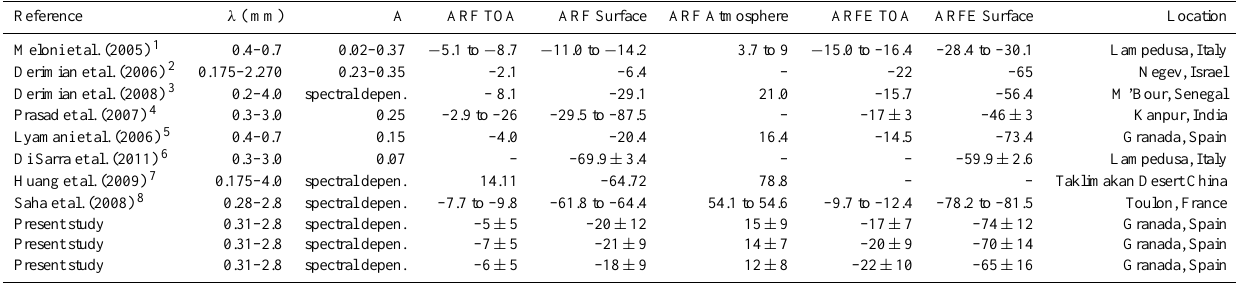
Method: 1 Surface albedo varies between 0.02 at 20 ◦ and 0.37 at 90 ◦ SZA. 2 Mixture of desert dust and anthropogenic aerosol. 3 Takes into account the nonsphericity of dust particles for simulating radiative effects. 4 The ω(λ) (coarse mode) was found to increase with the arrival of dust storms and have a pronounced effect at higher wavelengths. 5 Fixed surface albedo of 0.15. 6 Surface albedo has been calculated as the weighted average of land and ocean albedo over a 10km diameter area around the measurement site. 7 Takes into account the vertical distributions of the dust aerosol extinction coefficient. 8 The single scattering albedo at 525nm ranged between 0.7 and 0.8, indicating significant